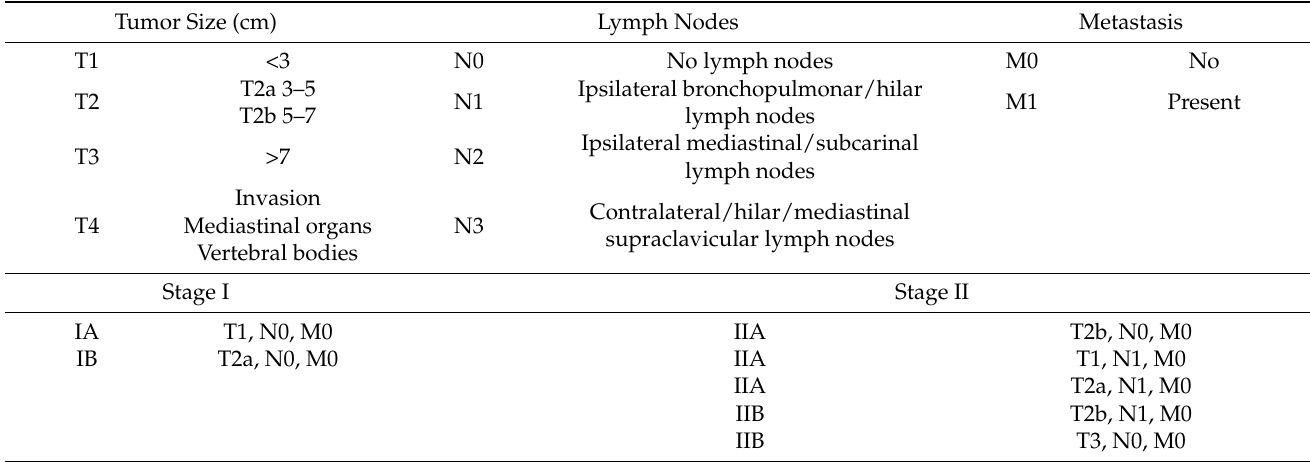
Table 1. TNM of malignant tumor